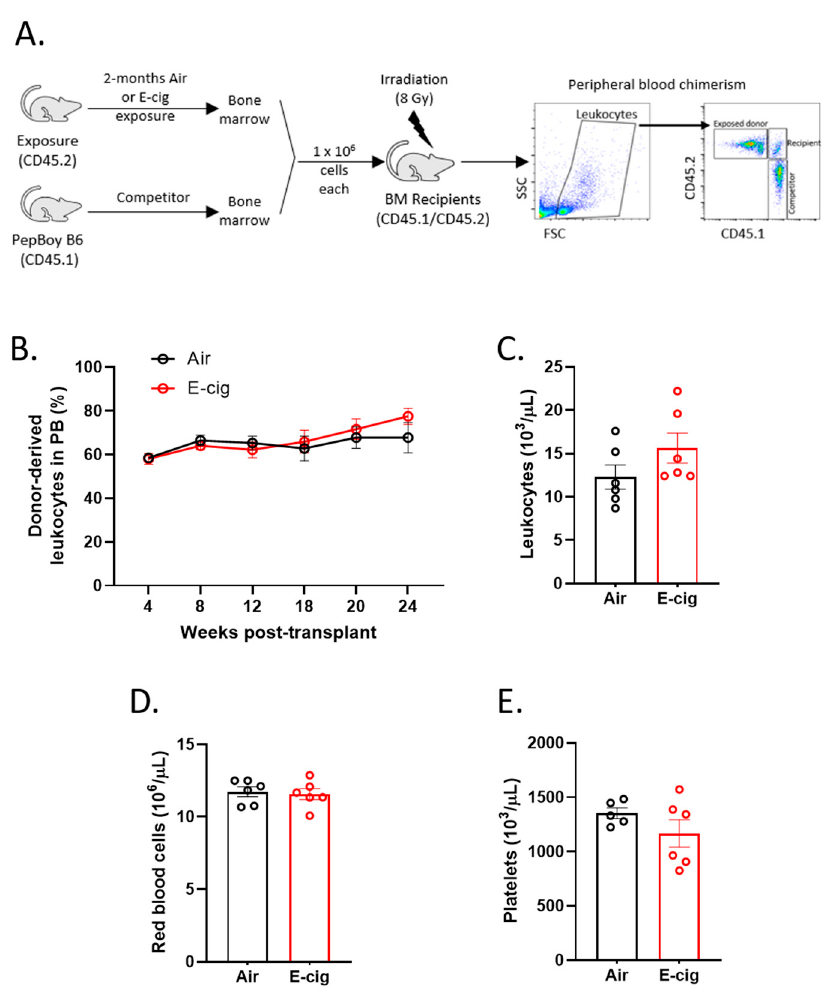
Figure 4. HSC function is unperturbed following E-cigarette exposure. ( A ) Competitive transplant set-up and peripheral blood (PB) chimerism analysis. ( B ) PB chimerism of CD45.2 leukocytes post- transplant. Peripheral blood cell counts of ( C ) leukocytes, ( D ) red blood cells and ( E ) platelets at 20 weeks post-transplant. Data are shown as mean ± SEM, n = 5–6 mice/group. BM, bone marrow.